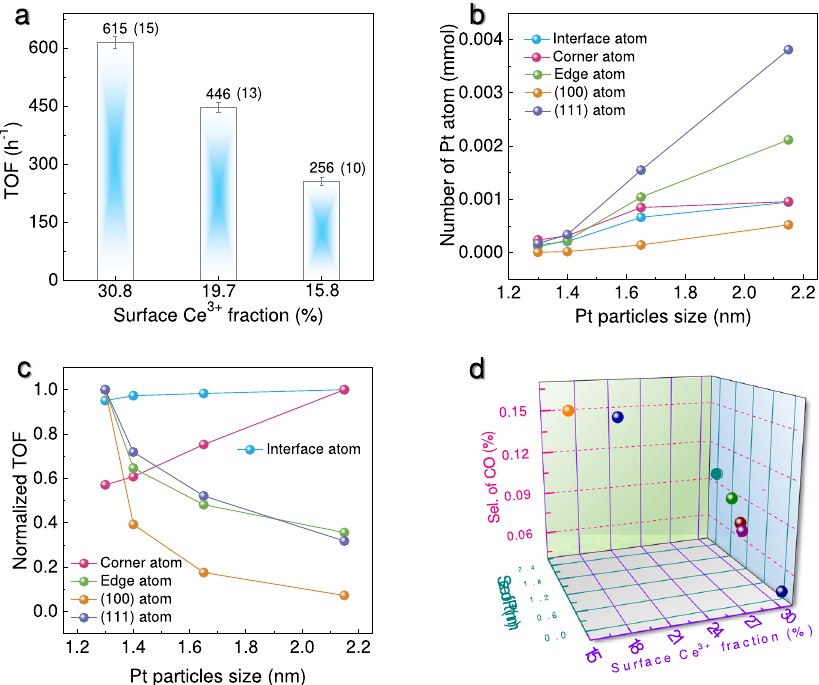
Fig. 4 | The in fl uence of dual-active sites on the H 2 generation performance. a Plots of TOF with surface Ce 3+ fraction. The error is derived from three parallel experiments. b PlotsofnumberofsurfaceatomspermoleofPtwithPtparticlesize